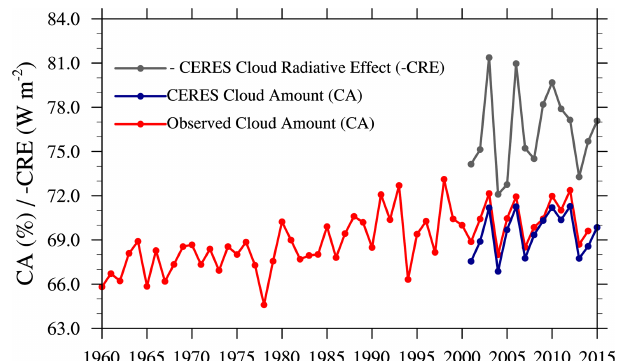
Figure 10. The cloud amount (CA) from CERES (blue line) agrees well with that derived from surface observations (red line) over Japan. At the annual timescale, the negative cloud radiative effect (-CRE, grey line) in CERES correlated well with the cloud